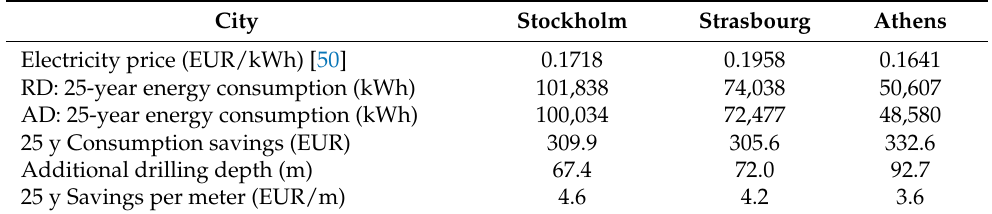
Table 8. The financial savings per meter generated in 25 years. Reference vs. alternative